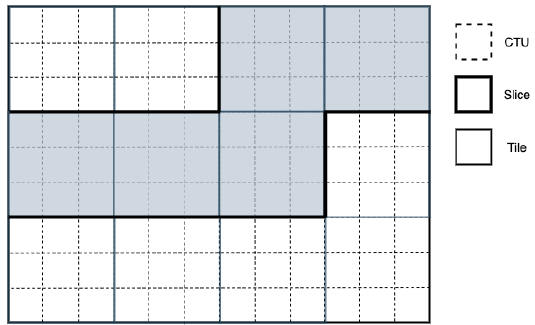
Figure 1. Example of raster-scan slice partitioning (12 tiles, 3 raster-scan slices).